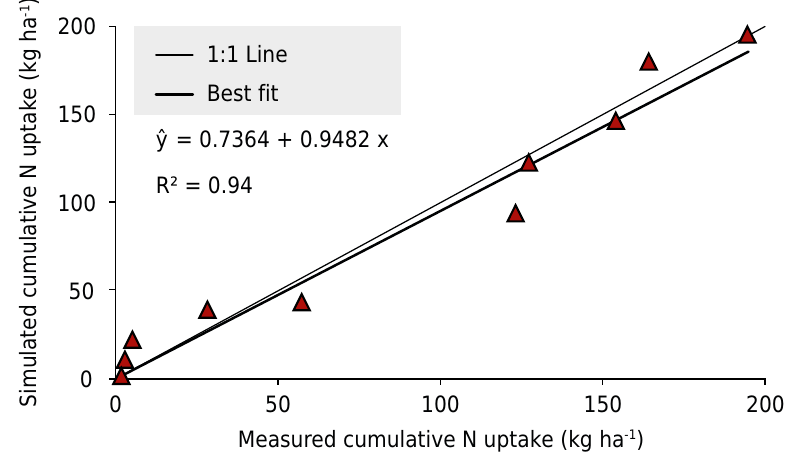
Figure 10. Overall comparison of cumulative nitrogen uptake between measurement and